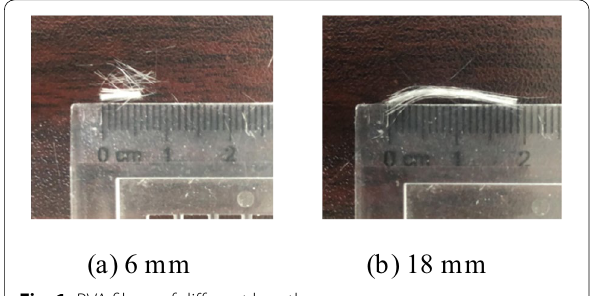
Fig. 1 PVA fibers of different